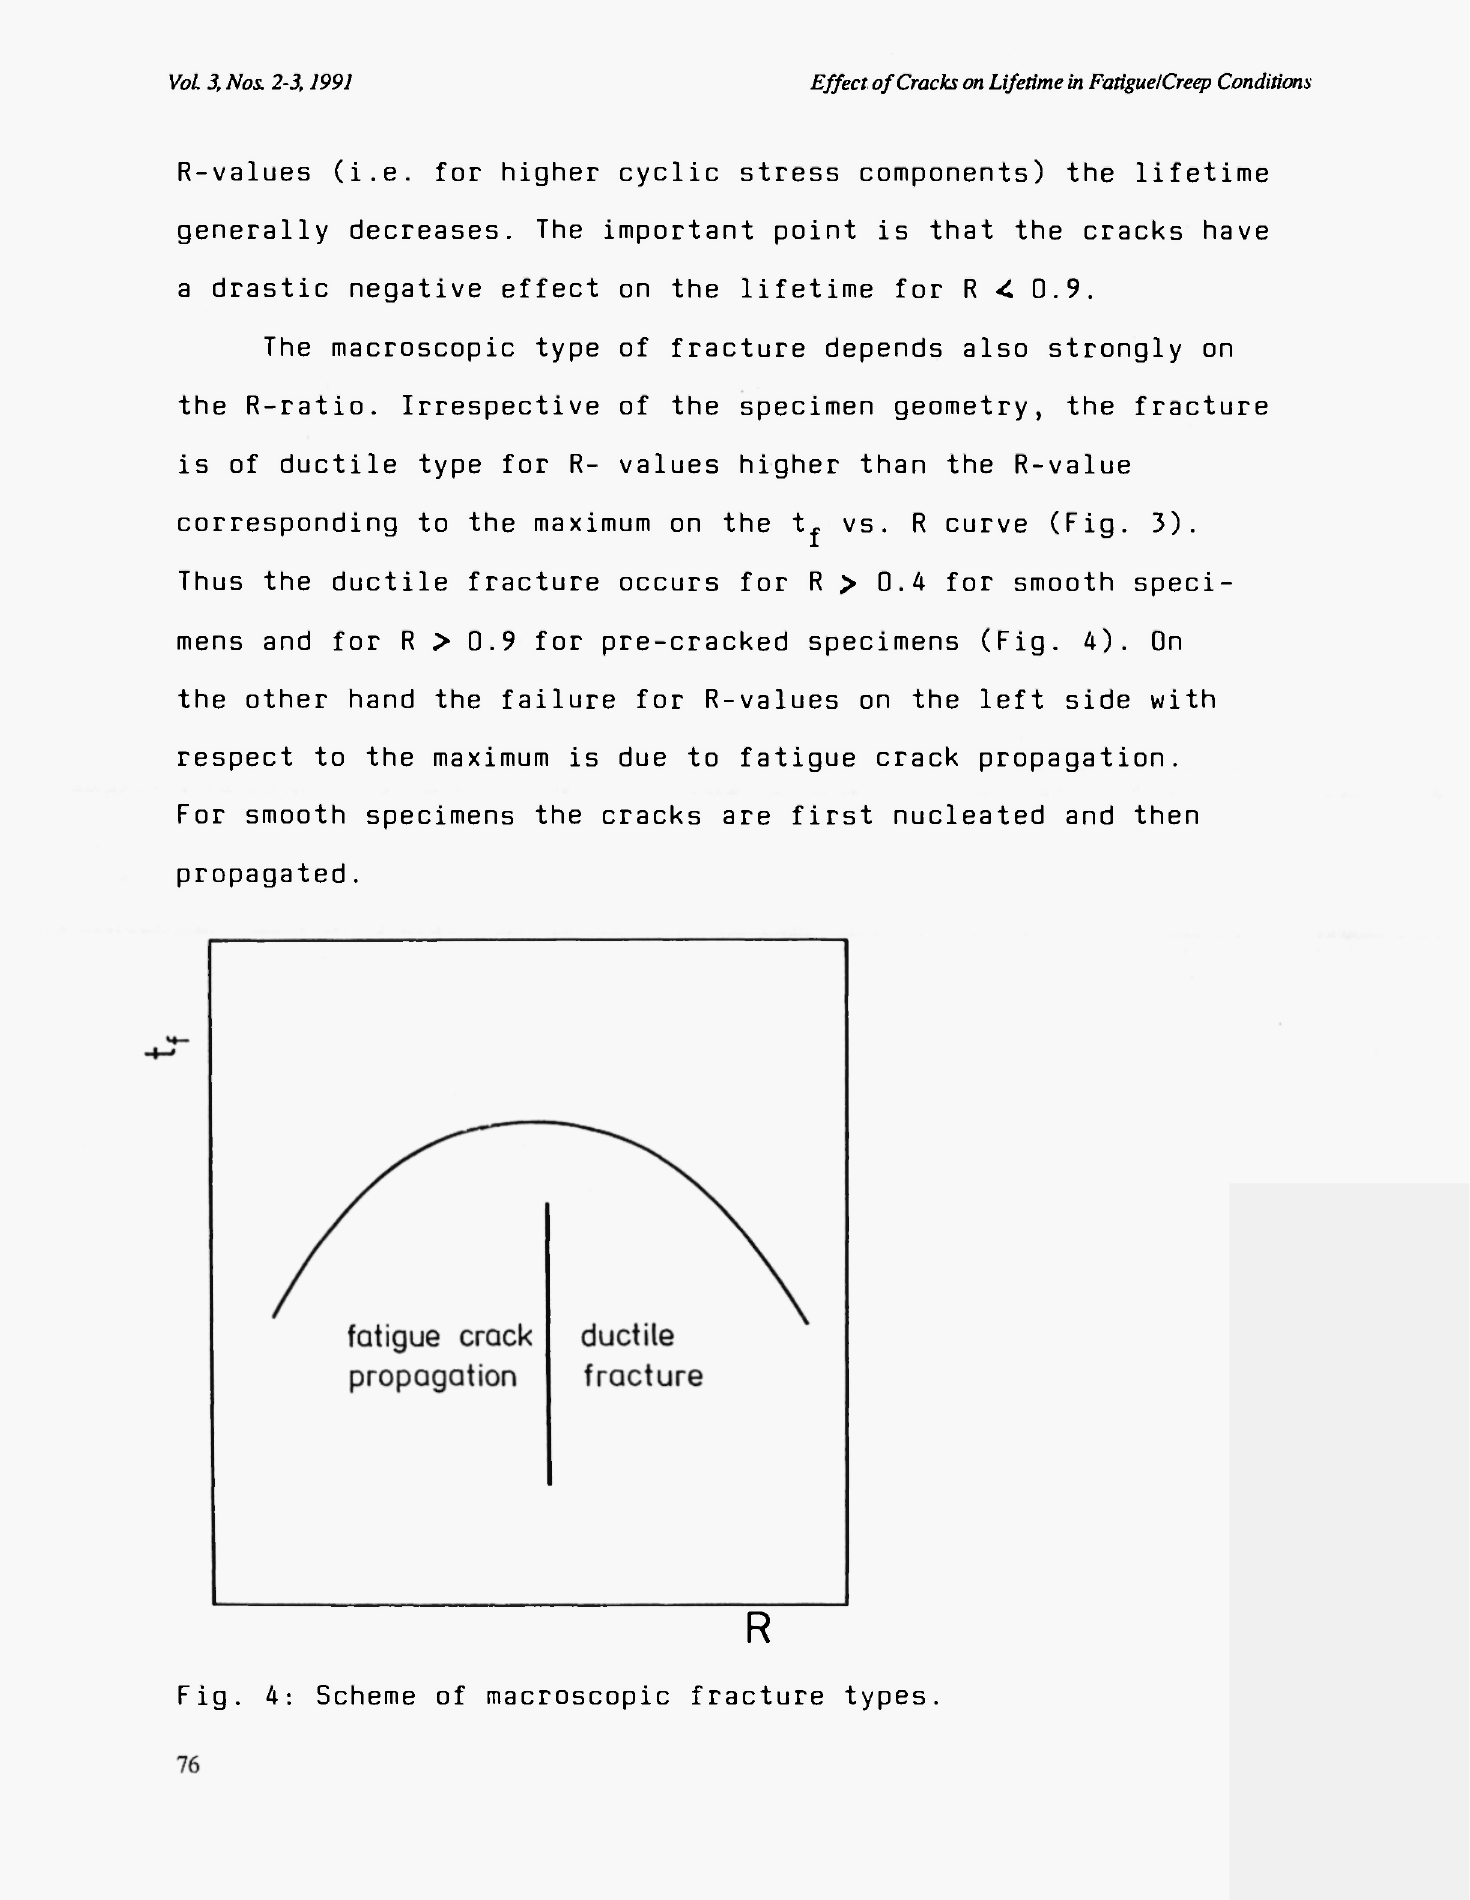
Fig. 4: Scheme of macroscopic fracture